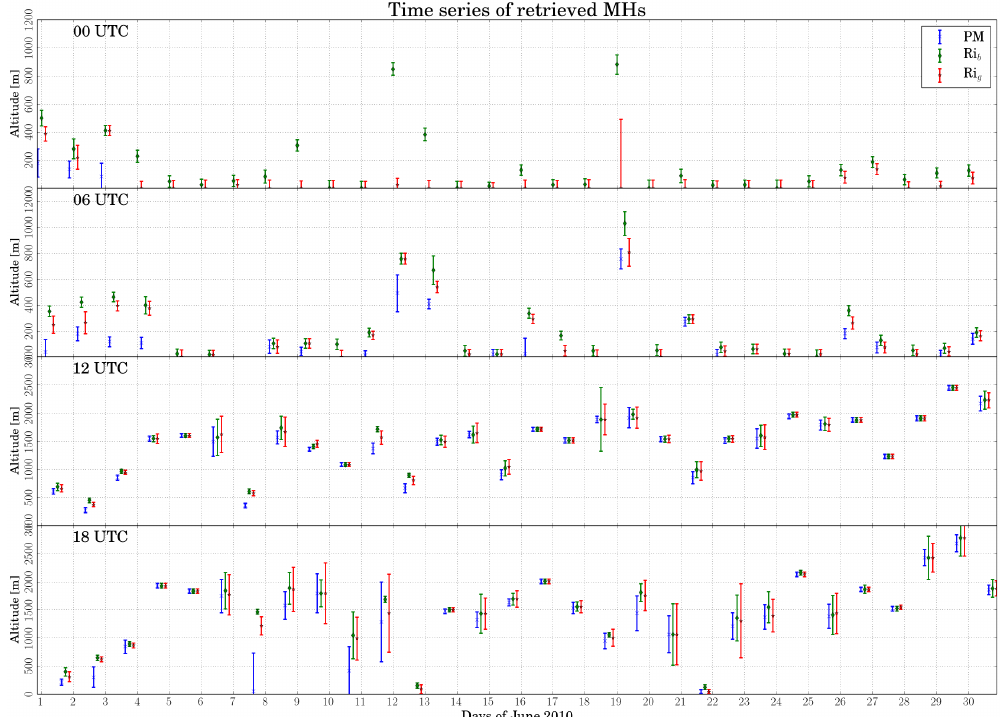
Figure 10. Time series of MHs calculated with three methods: blue is the parcel method (PM), green the Ri b , and red the Ri g . It presents the results obtained from the raw data without smoothing. The error bars represent the localization error calculated with Eq. (7).